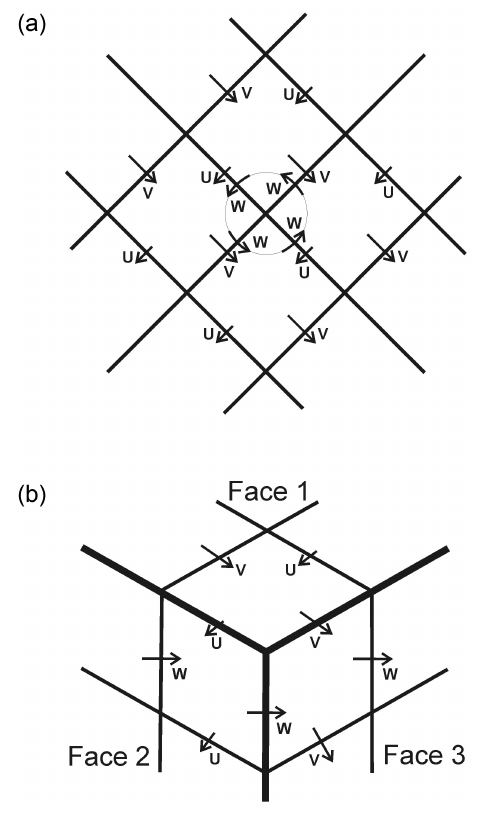
Figure 1. Upper diagram shows arrangement of velocity compo- nents on Face 1 of cubed-sphere grid centered around the North Pole. Lower diagram shows arrangement of velocity components at the intersection of Faces 1, 2, and 3. Although U , V , and W are defined everywhere except at their poles, only the component per- pendicular to an edge is displayed.